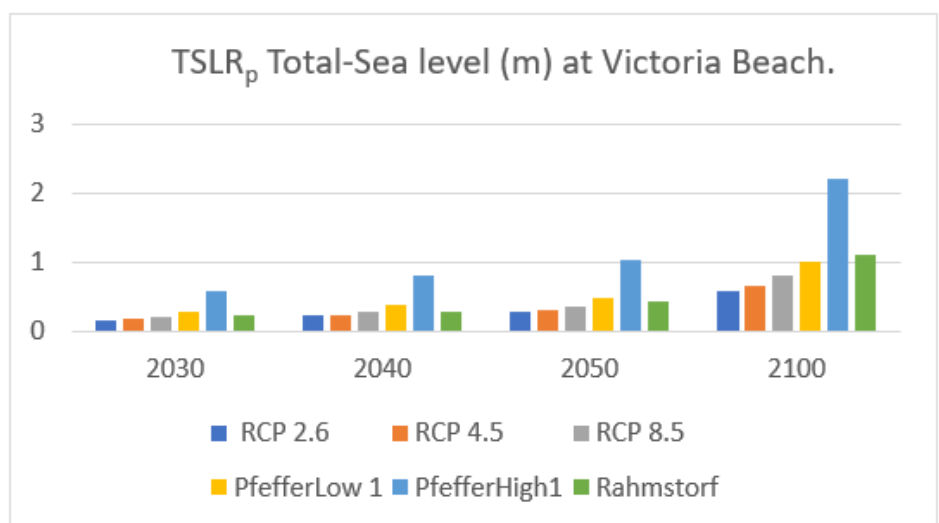
Figure 5. Total Sea-Level Rise (m) (TSLR P ) at Victoria Beach projected for the years 2030, 2040, 2050, and 2100, according to the different models and scenarios.